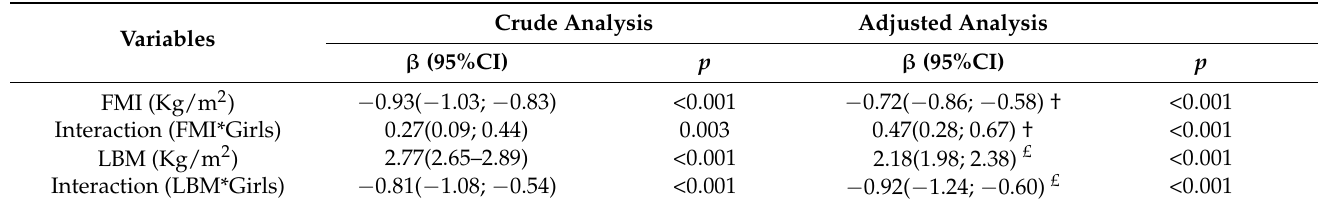
Table 2. Crude and adjusted analysis of the relationship of anthropometric parameters associated